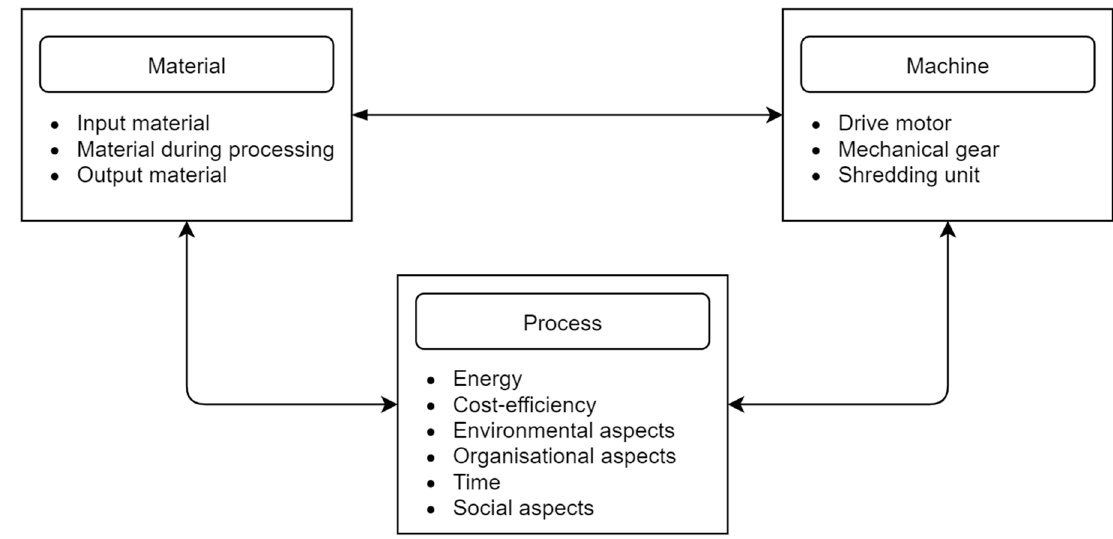
Figure 19. The objects in shredding processes in disturbed polymer material recycling and their relations.